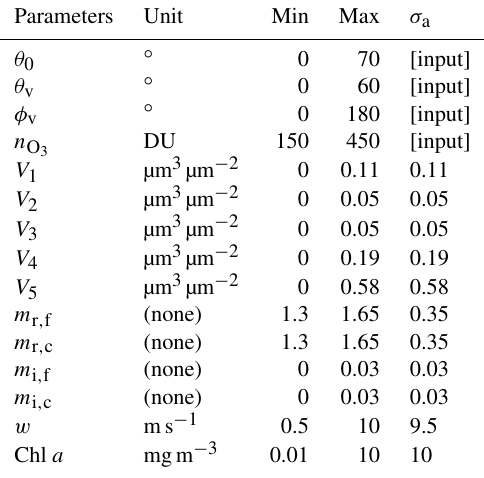
Table A1. Parameters used to train the FastMAPOL forward model. The minimum (min) and maximum (max) values of each parame- ter are also shown. The a priori uncertainties ( σ a ) are estimated as the difference between the maximum and minimum values for the study, except the four parameters as indicated, which are assumed to be known